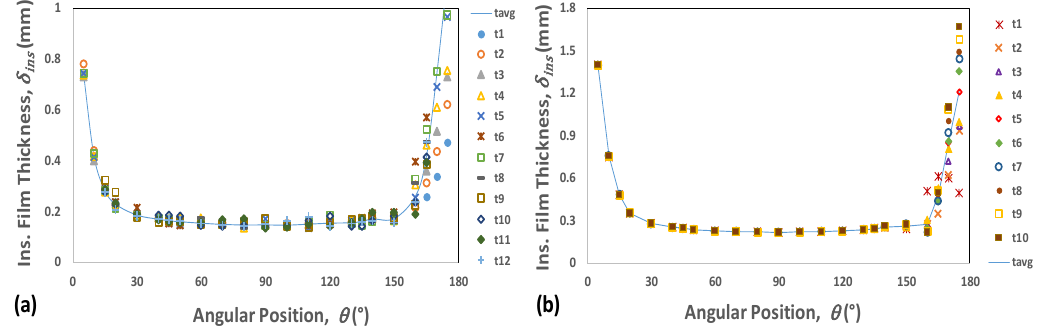
Figure 6. Film thickness at different times after the tube is completely covered and time-averaged film thickness profiles for Γ 1 / 2 = 0.01 kg/(m·s) and ( a ) C = 0.45, and ( b ) C = 0.65.